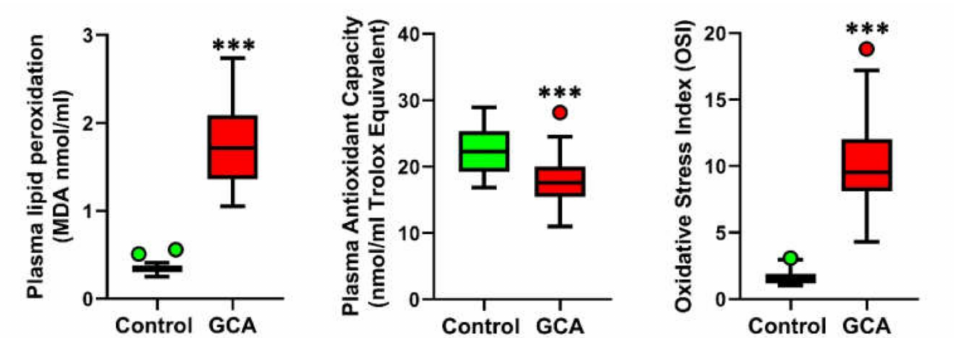
Figure 2. Plasma lipid peroxidation, plasma total antioxidant capacity and Oxidative Stress Index in the GCA patients ( n = 30) and controls ( n = 30). *** p <